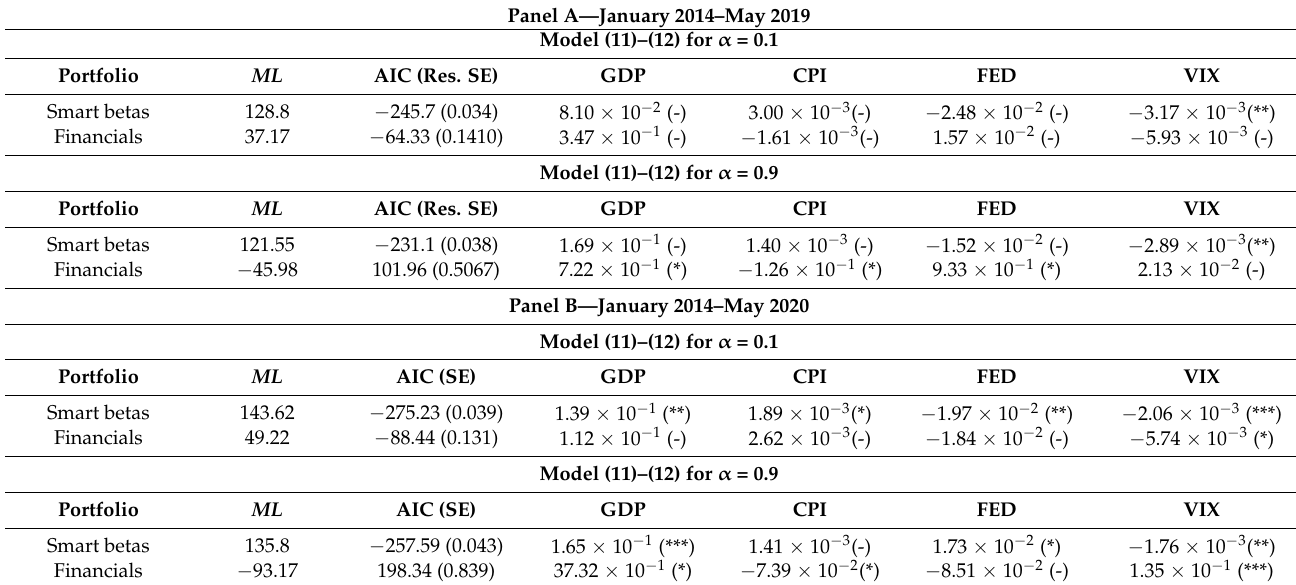
Table 10. Results of model (11)–(12) (Panels A and B) applied to smart beta and financial ETF portfolios. Panel A includes